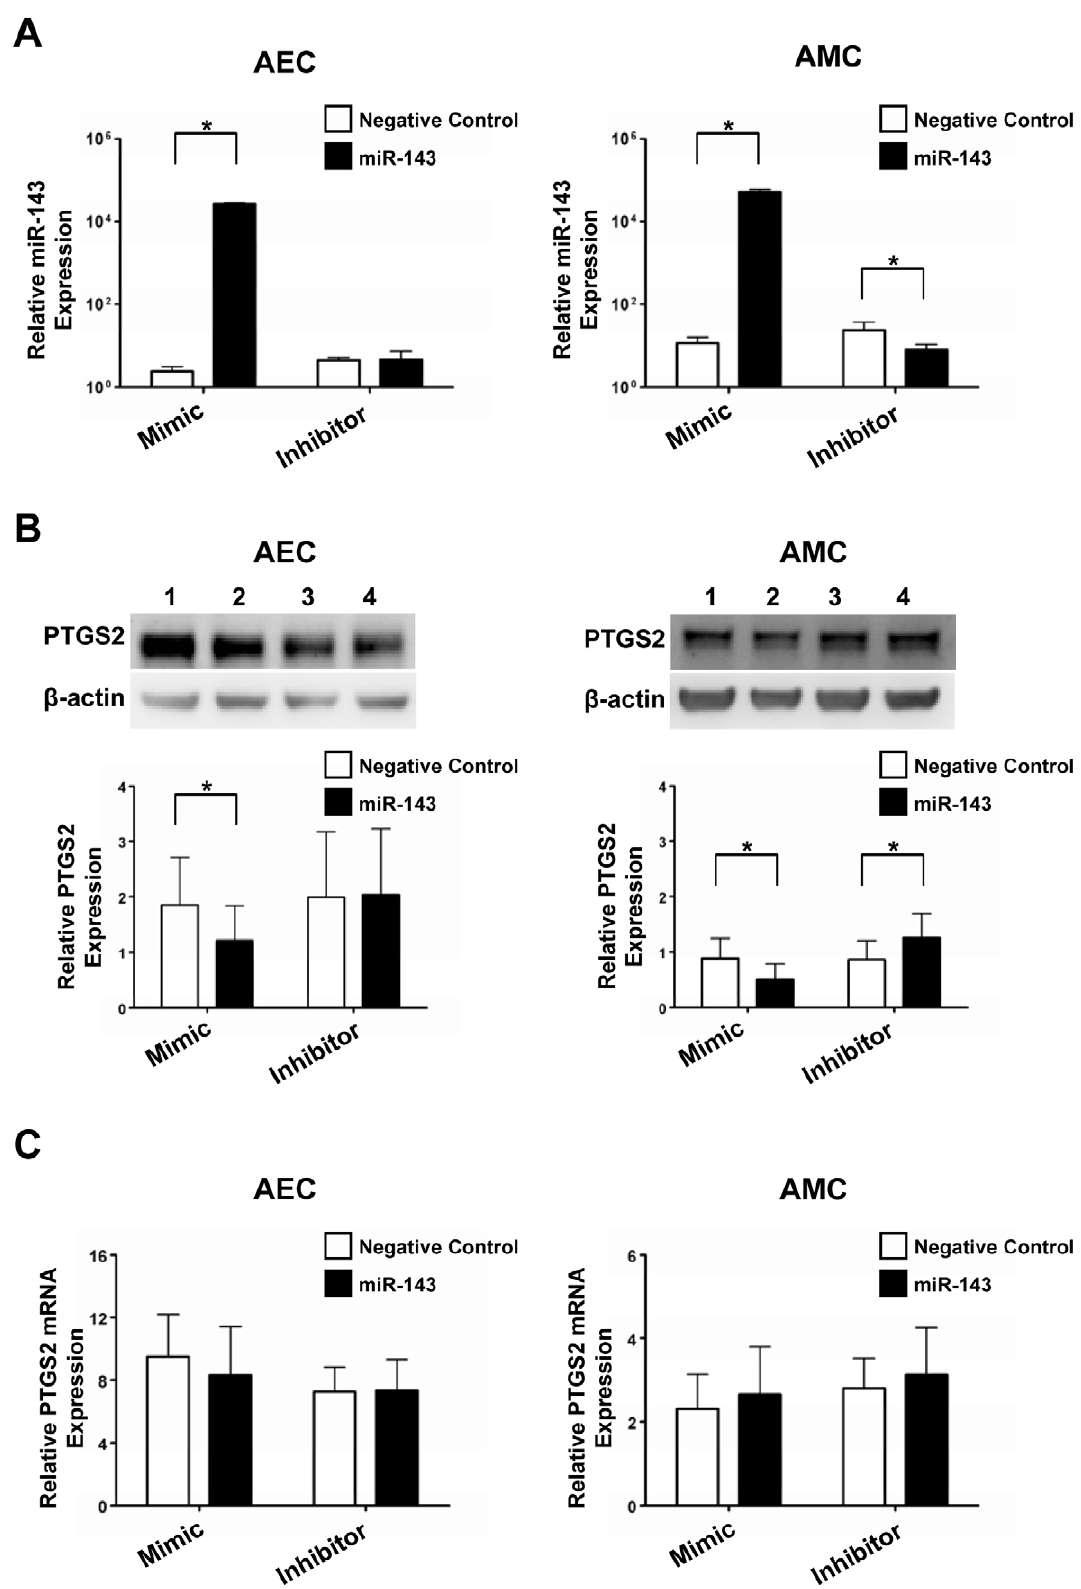
Figure 4. Effects of miR-143 on PTGS2 expression in AECs and AMCs. A, qRT-PCR analysis shows that 50 nM of miR-143 mimic transfection significantly increases miR-143 expression, while transfection with 200 nM of miR-143 inhibitor has no effect in AECs. In AMCs, miR-143 mimic (50 nM) and hairpin inhibitor (200 nM) transfections significantly increased and decreased the expression of miR-143, respectively. miR-143 and miR-